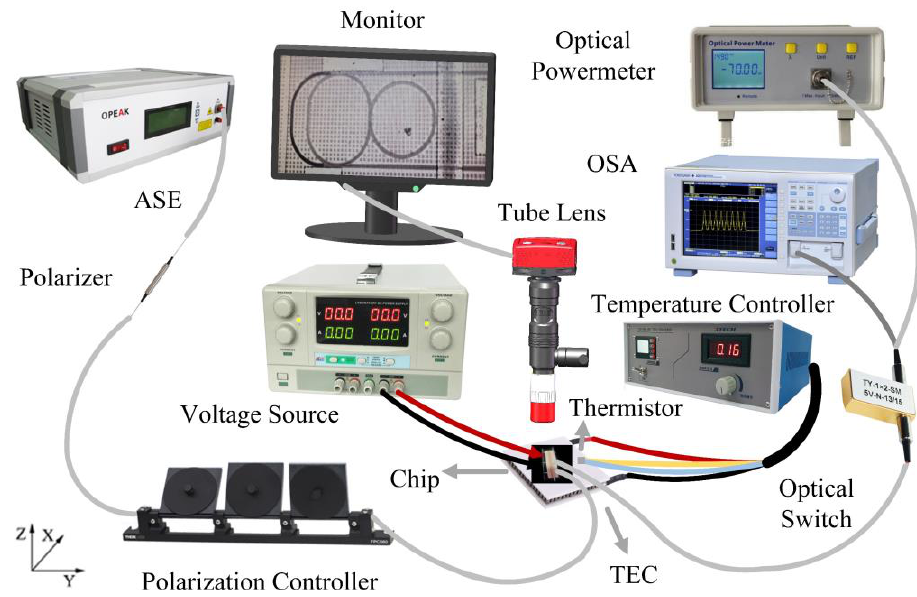
Figure 4. Schematic view of the experimental facility for device performance measurement.